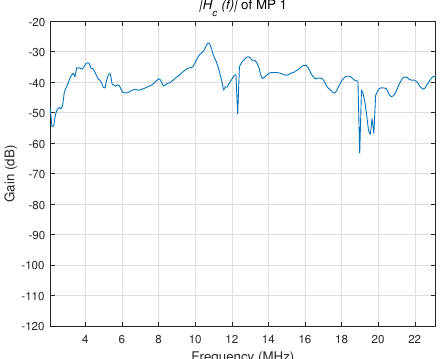
Figure 6. Magnitude response | Hc ( f k ) | through the power line and receiver coupler from (3).